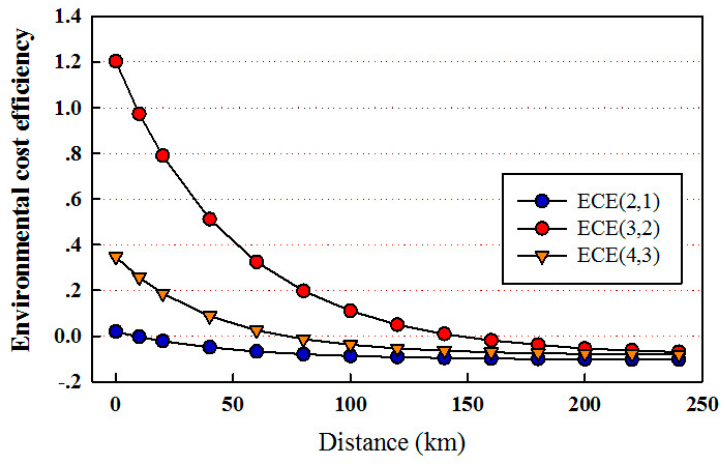
Figure 2. ECE evaluation results for the WWTP case that was supposed to be built on the bank of small river (Ashihe river).